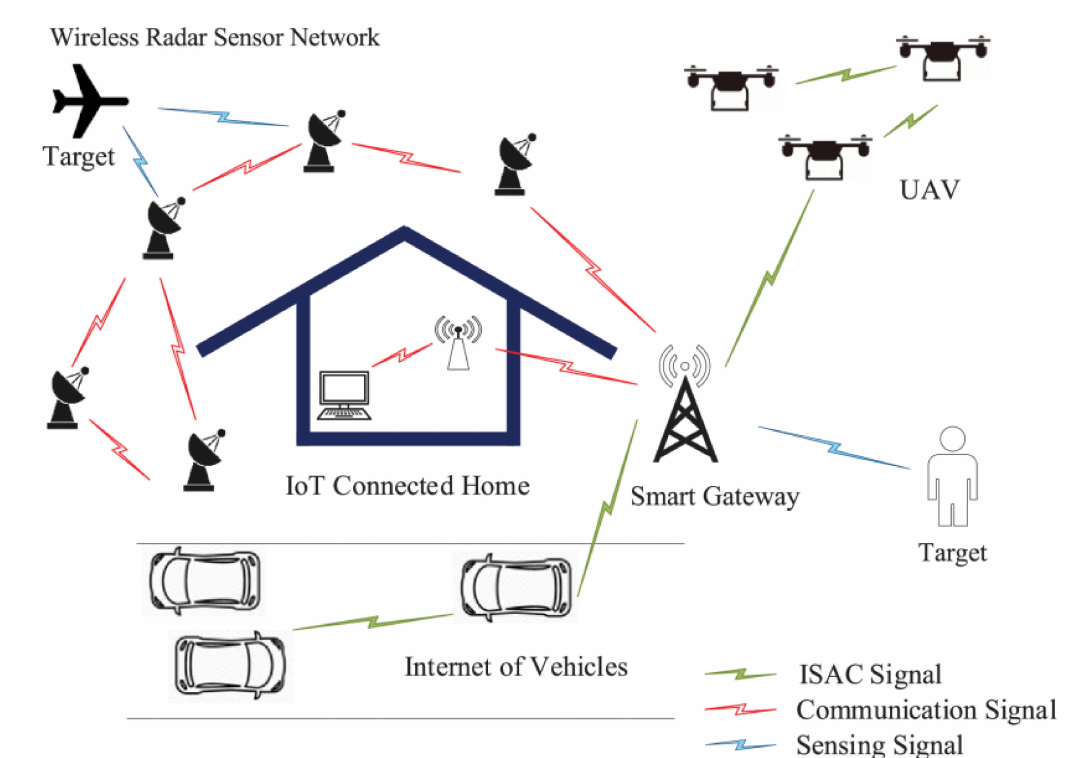
Figure 6. An illustration of the applications of ISAC